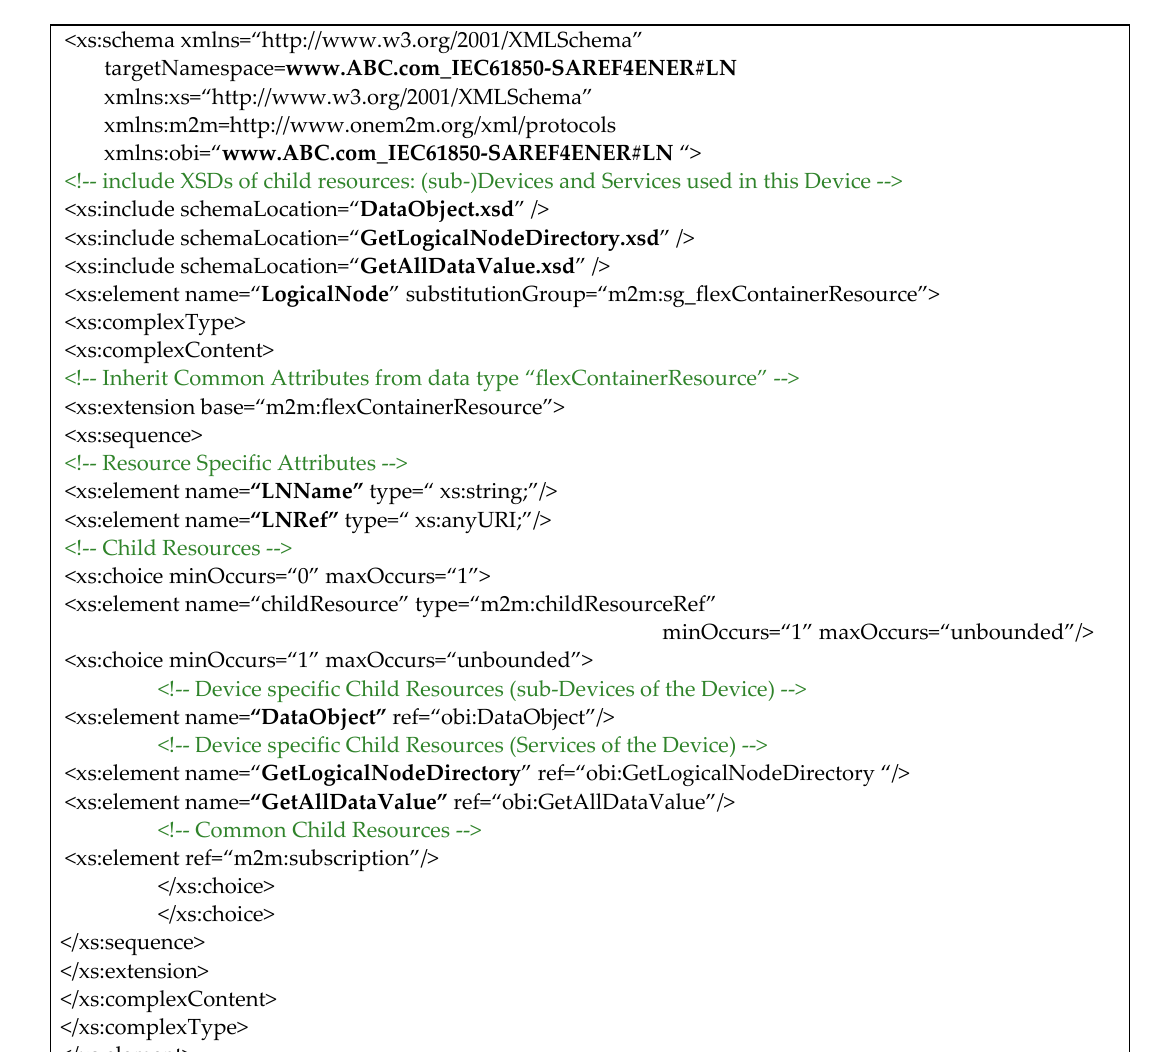
Figure 14. XSD file representing the iec61850s4ener: LogicalNode class as a <flexContainer> oneM2M resource.